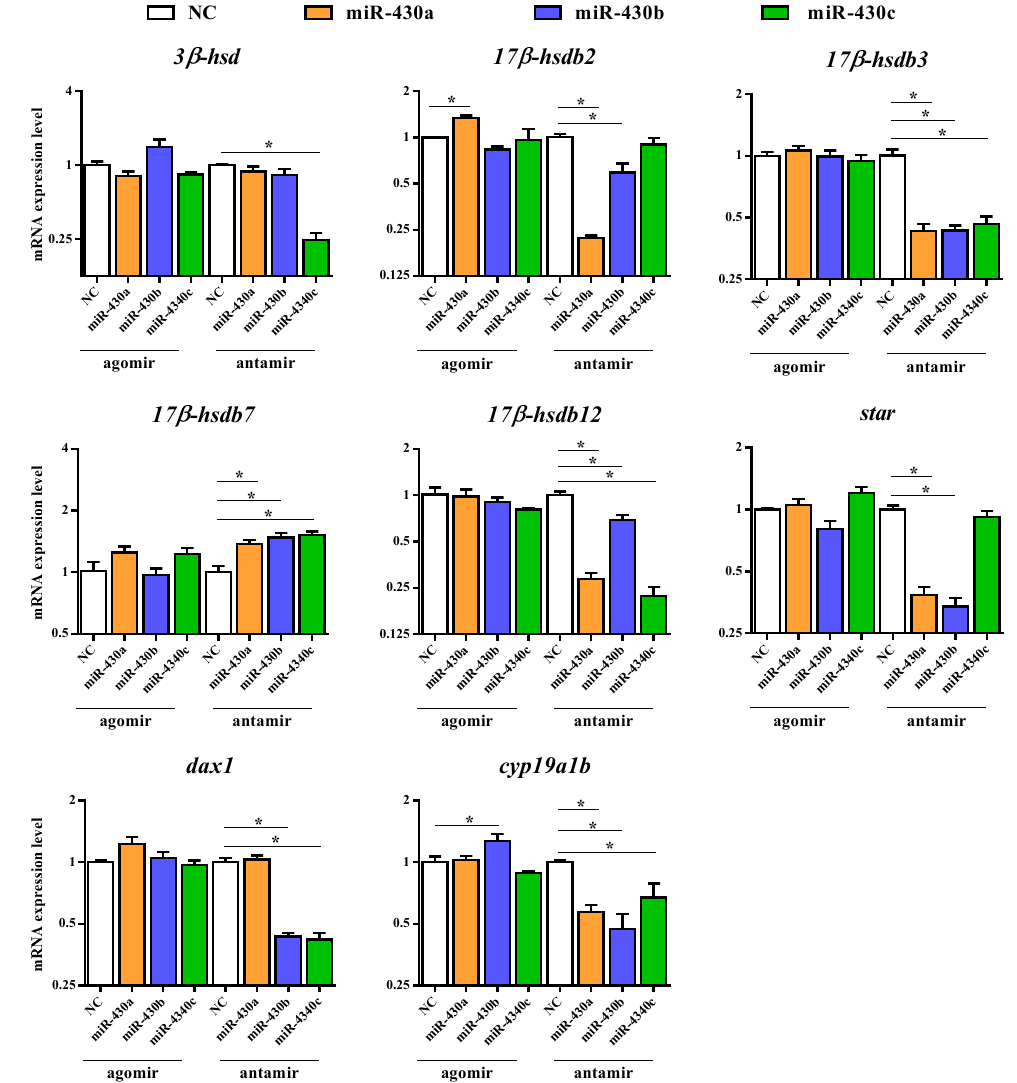
Figure 3. Candidate genes expression levels revealed by quantitative qPCR. The results of qPCR were performed by relative expression using β -actin and ef1a as the reference gene and measured by the method of optimized comparative Ct (2 - ∆∆ Ct ) value. Values are means ± SEM., n = 3. * p < 0.05.